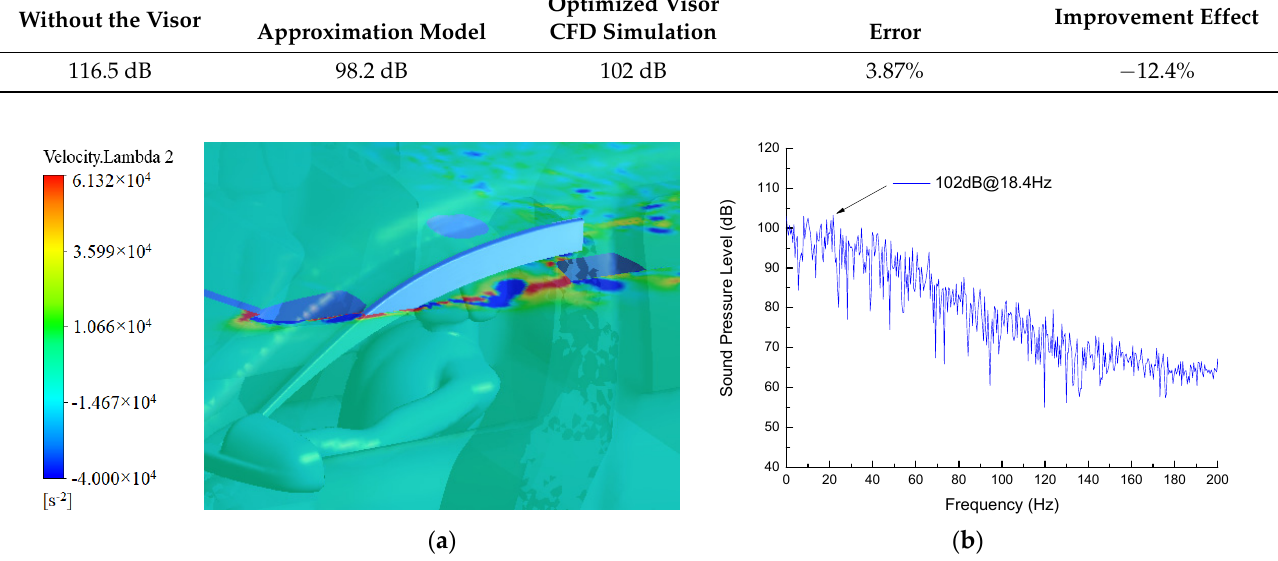
Figure 11. Noise reduction effect of the optimized visor. ( a ) The contour of velocity lambda2 at the Table 4. Comparison of optimization results. horizontal section of the driver’s ear; ( b ) Sound pressure level spectrum at the driver’s left ear